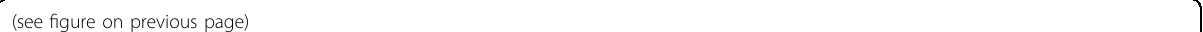
Fig. 2 BAK is required for dinaciclib-induced cell death in HER2 -ampli fi ed breast cancer cells and dinaciclib functions mainly by inhibiting MCL-1. A HCC-1419 and MDA-MB-453 cells were transduced with lentiviruses containing plasmids with an shRNA sequence targeting BAK or a non- targeting control. Puromycin-resistant cells were pooled after each infection. Cells were then treated with no drug, 1 μ M lapatinib, 100 nM dinaciclib or their combination overnight. Cell lysates were prepared and subjected to western blotting and probed for cleaved PARP, BAK, and GAPDH ( ‘’ No Rx ” : No drug). B HCC-1419 and MDA-MB-453 cells were treated with no drug, 1 μ M lapatinib, 100 nM dinaciclib, 10 μ M A1210477 and their combinations (lapatinib/dinaciclib and lapatinib/A1210477) overnight and CHAPS lysates (using the zwitterionic detergent CHAPS, that can solubilize cells without promoting signi fi cant conformational changes in BAX and BAK, including the N-terminal Bak epitope exposure recognized by antibody Ab-1) were prepared and subjected to AB-1 IP and western blotting. Total cell lysates were analyzed in parallel. C SKBR3 control or MCL-1-expressing cells were treated with 1 μ M lapatinib, 100 nM dinaciclib, and their combination for 12 h. Whole-cell lysates were prepared, subjected to western blotting and probed for the indicated proteins. D SKBR3 control or MCL-1-expressing cells were treated with 1 μ M lapatinib, 100 nM dinaciclib, and their combination for 12 h and subjected to CellTiter-Glo. n = 3; error bars indicate ±SD. E MDA-MB-453 control or MCL-1-expressing cells were treated with 1 μ M lapatinib, 100 nM dinaciclib, and their combination for 12 h. Whole-cell lysates were prepared, subjected to western blotting and probed for the indicated proteins. F MDA-MB-453 control or MCL-1-expressing cells were treated with 1 μ M lapatinib, 100 nM dinaciclib and their combination for 72 h and subjected to CellTiter-Glo. n = 3; error bars indicate ±SD. For Fig. 2D, F two-tailed Student ’ s t test was performed. p values were corrected for multiple testing using the Bonferroni method. Differences were considered statistically different if p < 0.05. A p value < 0.05 is indicated by *, p < 0.01 by **, p < 0.001 by ***, and p < 0.0001 by ****. EV: empty vector, ( + ): positive control, CHAPS: 3- ((3-cholamidopropyl) dimethylammonio)-1-propanesulfonic